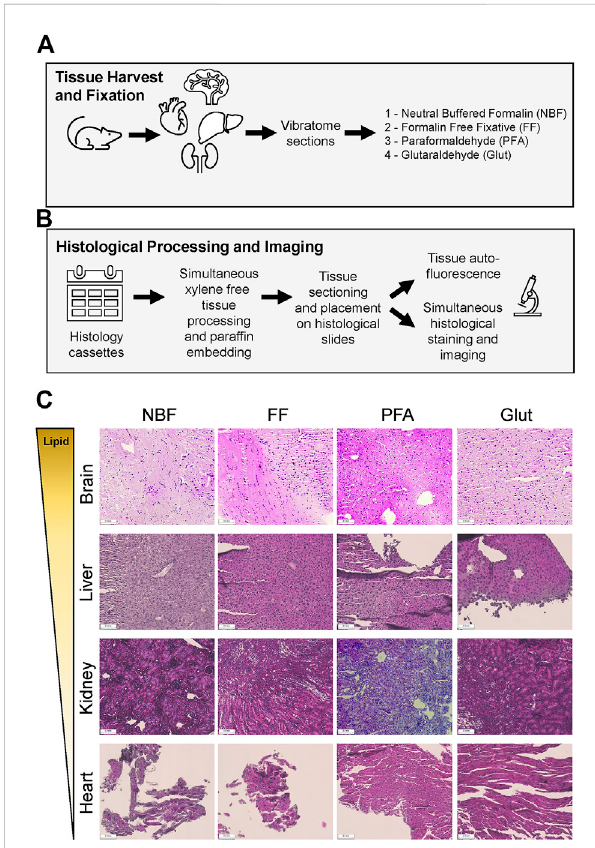
FIGURE 1 Fixation of native murine tissues of varying lipid-protein composition with different commercially available fi xatives. (A) Overview of tissue harvest (brain, heart, kidney and liver) from a single animal followed by vibratome slicing and then fi xation of neighboring sections using one of four commercially available fi xatives (detailed in Table 1). (B) Overview of histological processing work fl ow to generate tissue microarrays (TMAs) for assessing tissue auto fl uorescence with different fi xatives and simultaneous staining with hematoxylin and eosin (H&E) and imaging. (C) Organs are arranged from highest to lowest lipid content. H&E images acquired using a ×20 objective on a Nikon Ts-2R inverted microscope with constant acquisition settings for all images. Scale bar is 100 μ m for all images. Schematic in (A) and (B) made using Microsoft Icons by the